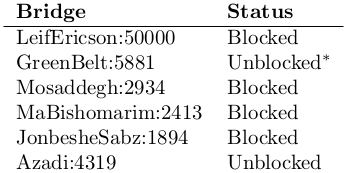
Table from the paper: Detecting Censor Detection
Table text:
Bridge
Status
LeifEricson:50000
Blocked
GreenBelt:5881
Unblocked ∗
Mosaddegh:2934
Blocked
MaBishomarim:2413
Blocked
JonbesheSabz:1894
Blocked
Azadi:4319
Unblocked